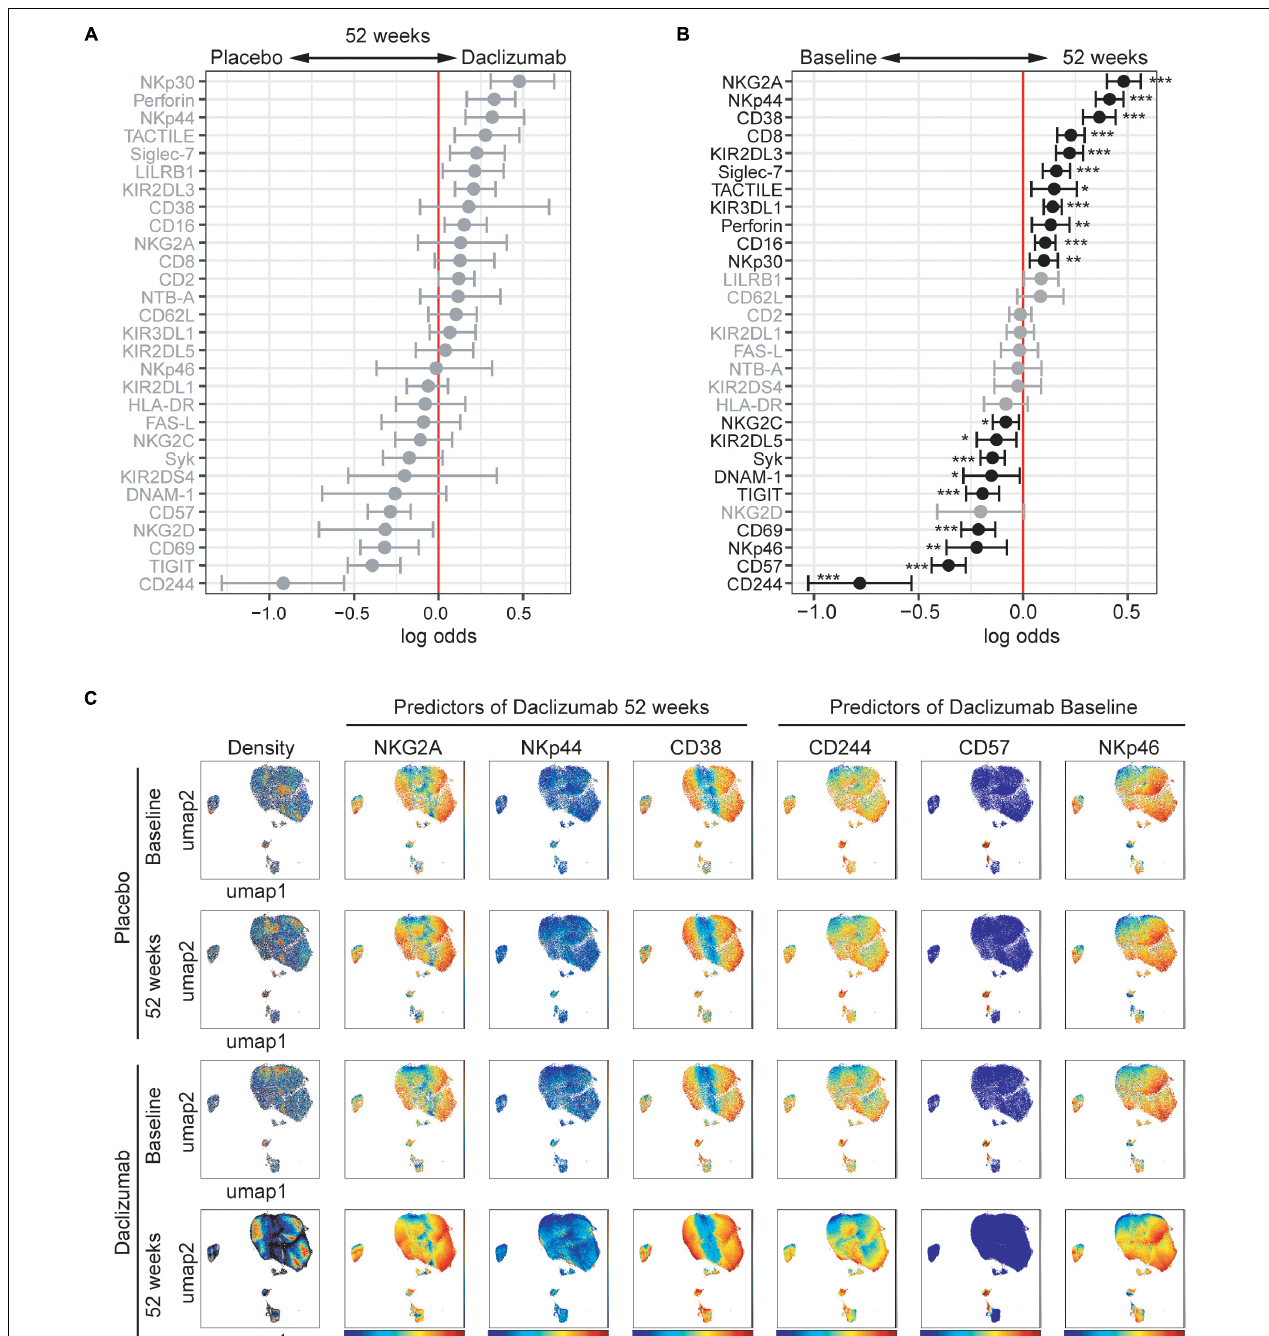
FIGURE 2 | Daclizumab beta alters the CD56 bright population. (A) A generalized linear model with bootstrap resampling was used to identify NK markers on CD56 bright NK cells predictive of daclizumab beta- and placebo-treated individuals at 52 weeks of treatment. CD56 bright NK cells were used with no subsampling. Placebo: 24 weeks, n = 14; 52 weeks, n = 16. Daclizumab beta: 24 weeks, n = 25; 52 weeks, n = 27. Gray lines indicate markers with adjusted p-values > 0.05. Black lines indicate markers with adjusted p -values < 0.05. (B) A generalized linear mixed model with paired comparison was used for analyses of the same individual over time, comparing baseline and 52 weeks of daclizumab beta treatment. CD56 bright NK cells were used with no subsampling. Daclizumab beta baseline vs. 52 weeks, n = 22. Gray lines indicate markers with adjusted p-values > 0.05. Black lines indicate markers with adjusted p -values < 0.05. (C) UMAP visualizations of CD56 bright NK cells from the placebo at baseline (top row) and 52 weeks (second row), or the daclizumab beta-treated at baseline (third row) and 52 weeks (bottom row) groups. Leftmost panels are colored by cell density. NKG2A, NKp44, and CD38 were predictors of 52 weeks of daclizumab beta treatment. CD244, CD57, and NKp46 were predictors of baseline samples. Each plot is colored by marker expression, with color scale consistent between groups but specific for each marker. *Adjusted p -value < 0.05, **adjusted p -value < 0.01, ***adjusted p -value < 0.001. Adjusted p -values calculated using Benjamini-Hochberg method with FDR =